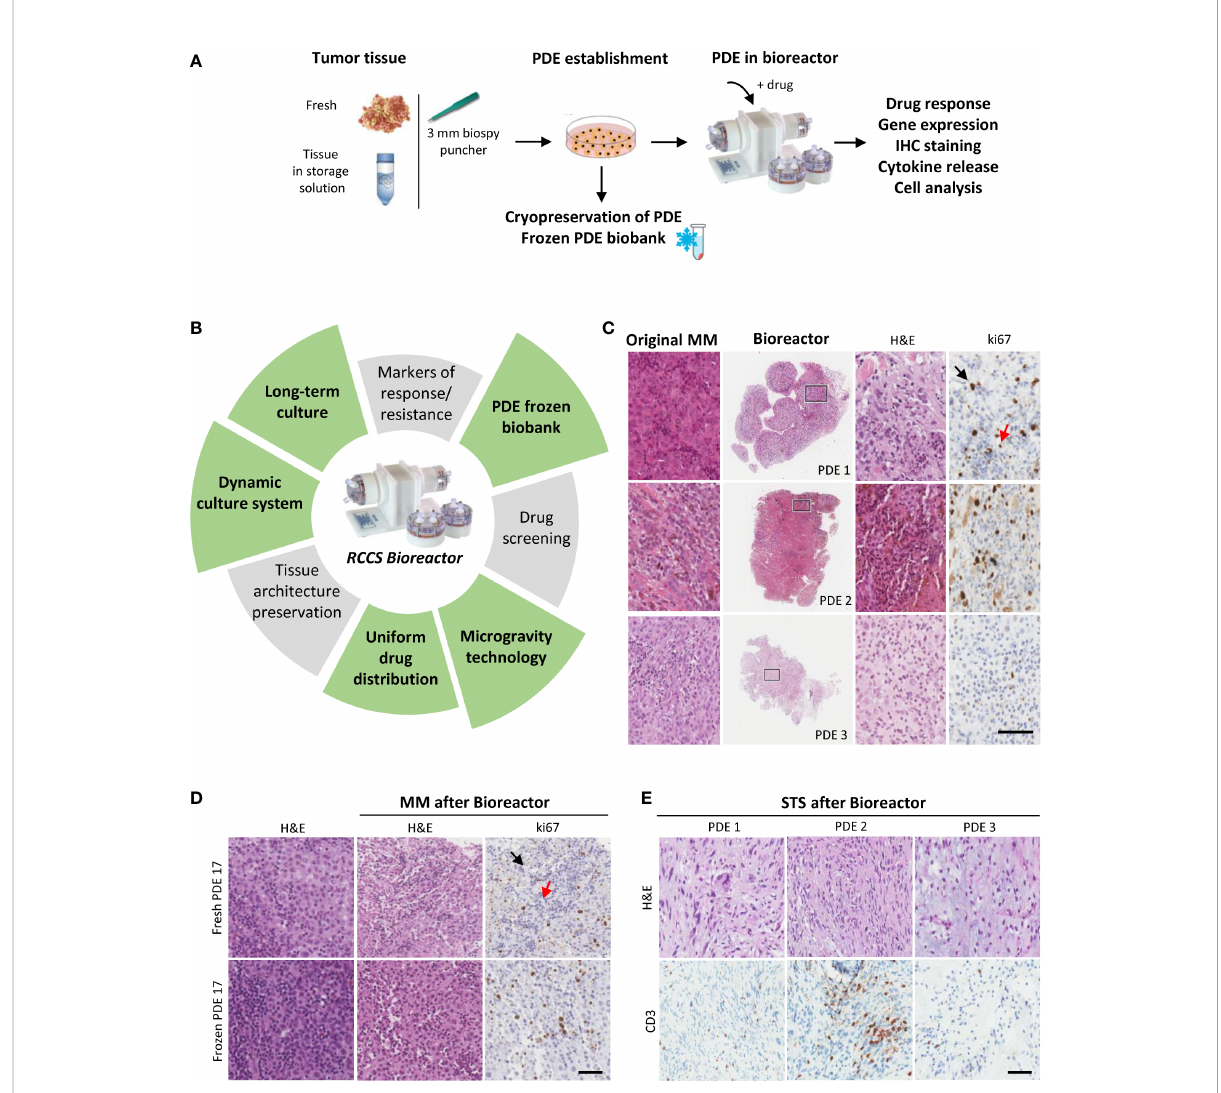
FIGURE 1 Dynamic 3D culture of PDE in RCCS Bioreactor preserves TIME architecture of MM and STS. (A) Strategy to establish tumor PDE to evaluate drug effects after culture in Bioreactor. (B) Main features common of PDE cultures (grey sectors) and those speci fi c of PDE cultured in RCCS Bioreactor (green sectors). (C) Representative histological images of MM PDE after 3 days culture in Bioreactor compared to the original tumors. Right panels show higher magni fi cation of the marked areas. (D) Representative images of ki67 stained fresh or frozen MM PDE before and after culture in Bioreactor. (E) Representative images of CD3 staining of frozen STS PDE after culture in Bioreactor. PDE 1: ckSTS, a myxo fi brosarcoma of the extremities; PDE2: ckSTS, a retroperitoneal dedifferentiated liposarcoma; PDE 3: skSTS, a myxoid liposarcoma of the extremities. Ki67 staining of proliferating tumor cells and lymphocytes are indicated by black and red arrows, respectively. H&E, hematoxylin and eosin. Scale bar 80 m M (C) , and 200 m M (D, E)